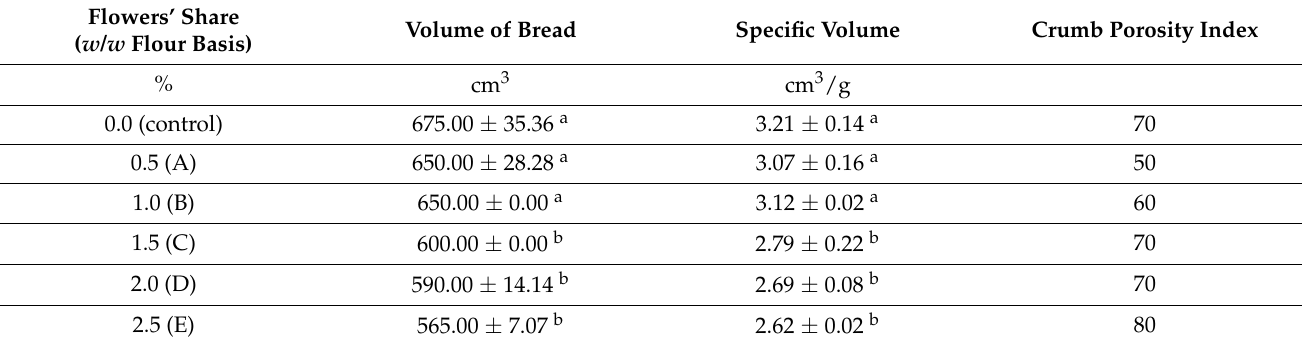
Table 2. The quality parameters of wheat dough enriched with J. regia male